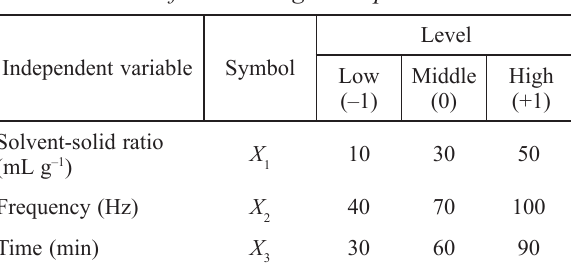
Table 1 – Coded and real levels of independent vari­ ables for the designed experiment Independent